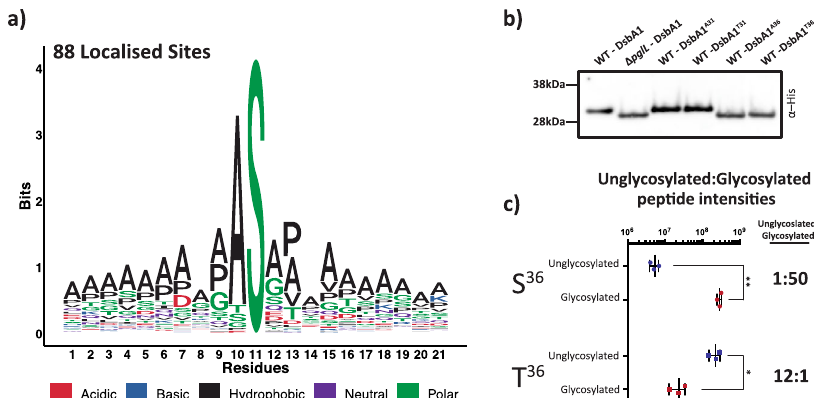
Fig. 2 O- linked glycosylation predominantly occurs on Serine residues across the B. cenocepacia glycoproteome. a Sequence analysis of localised glycosylation sites across B. cenocepacia strains reveals all assigned sites are Serine. b Western analysis of DsbA1 Nm -his 6 variants reveals substitution of only S 36 to Alanine or Threonine results in reduced glycosylation. c Relative amounts of the DsbA1 Nm -his 6 glycosylated and non-glycosylated peptides 23 VQTSVPADSAPAASAAAAPAGLVEGQNYTVLANPIPQQQAGK 64 and 23 VQTSVPADSAPAATAAAAPAGLVEGQNYTVLANPIPQQQAGK 64 observed within K56-2 WT reveals the alteration of S 36 to T 36 dramatically reduces glycosylation. Glycosylation site within peptides denoted by underlining. Differences in the abundance of glycosylated and non-glycosylated peptides containing S 36 to T 36 correspond to ( N = 3) biologically independent samples assessed using two-sided t-tests resulting in p-values of 0.0054 and 0.036